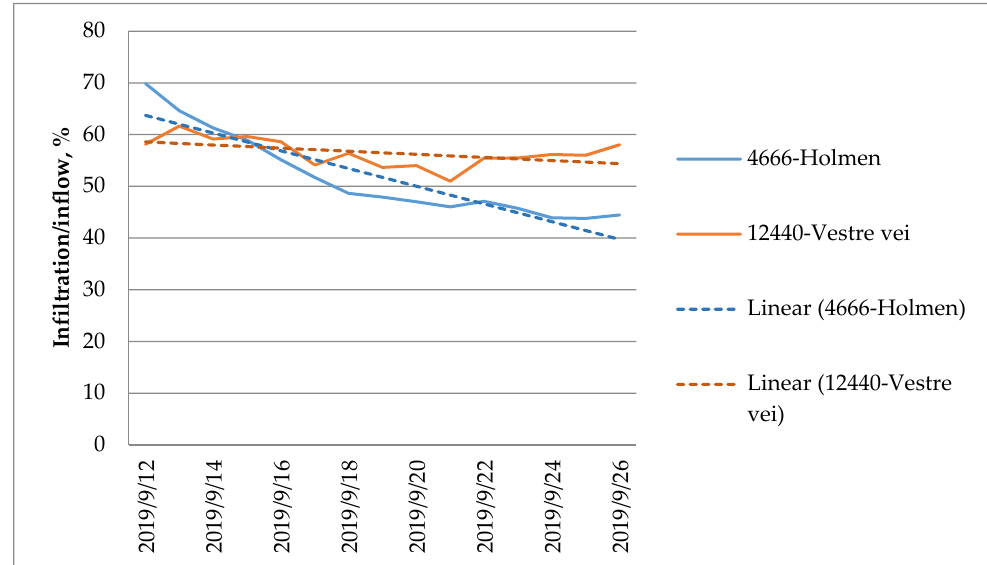
Figure 8. Calculated share of I/I-water in a dry period, after the implementation of the measures. In the period after the measures were implemented, the lowest estimated I/I-water level in Vestre vei was approximately 50%. In Holmen, the lowest level was approxi- mately 44%. The share of I/I-water in the Vestre vei zone was generally higher than in Holmen. The share of I/I-water for the Holmen zone was thus higher during this period than during the period prior to the measures being completed in Vestre vei. The share of I/I-water in Vestre vei remained rather stable before and after the implementation of the measures.